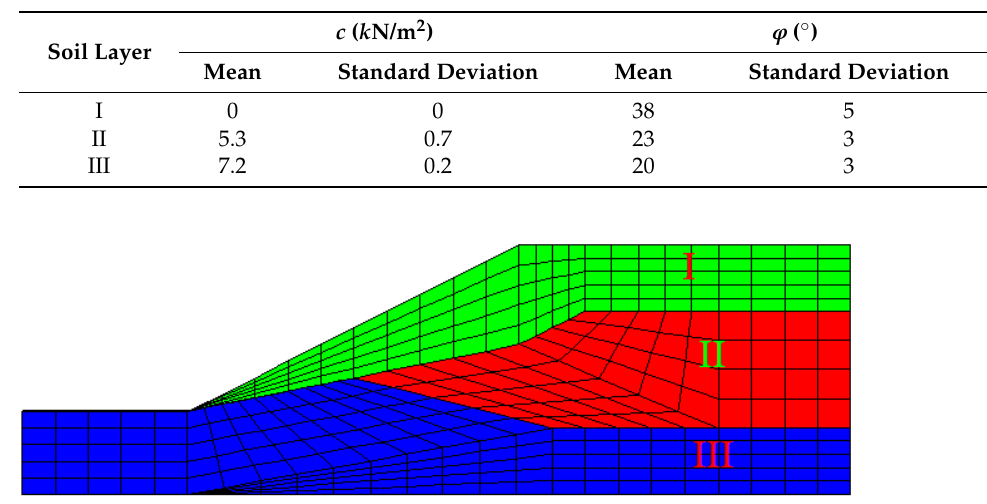
Table 9. The statistics property of random variables.